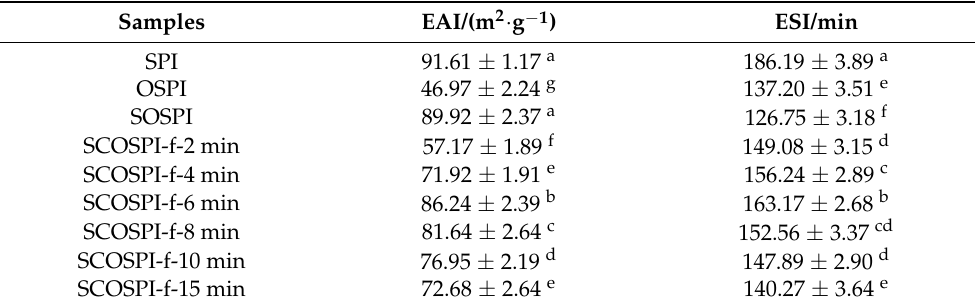
Table 4. Emulsion capacity and solidity of natural, oxidized soybean protein, and cavitation jet treated on soluble soybean protein oxidized accumulates at several times (2, 4, 6, 8, 10, and 15 min).